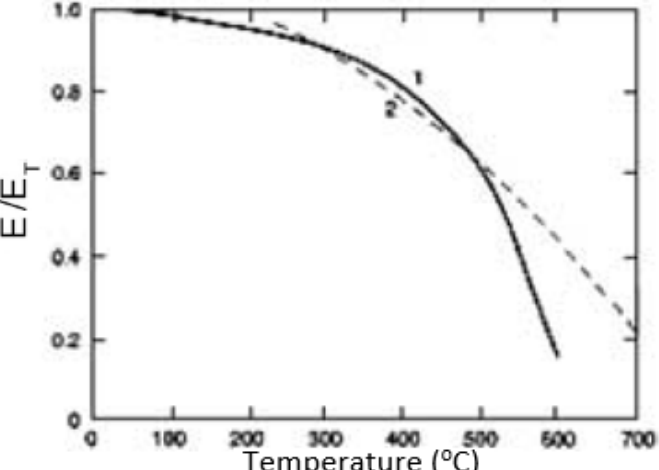
Figure 4. Outcome of temperature on the elastic modulus of structural steel and strengthening pieces